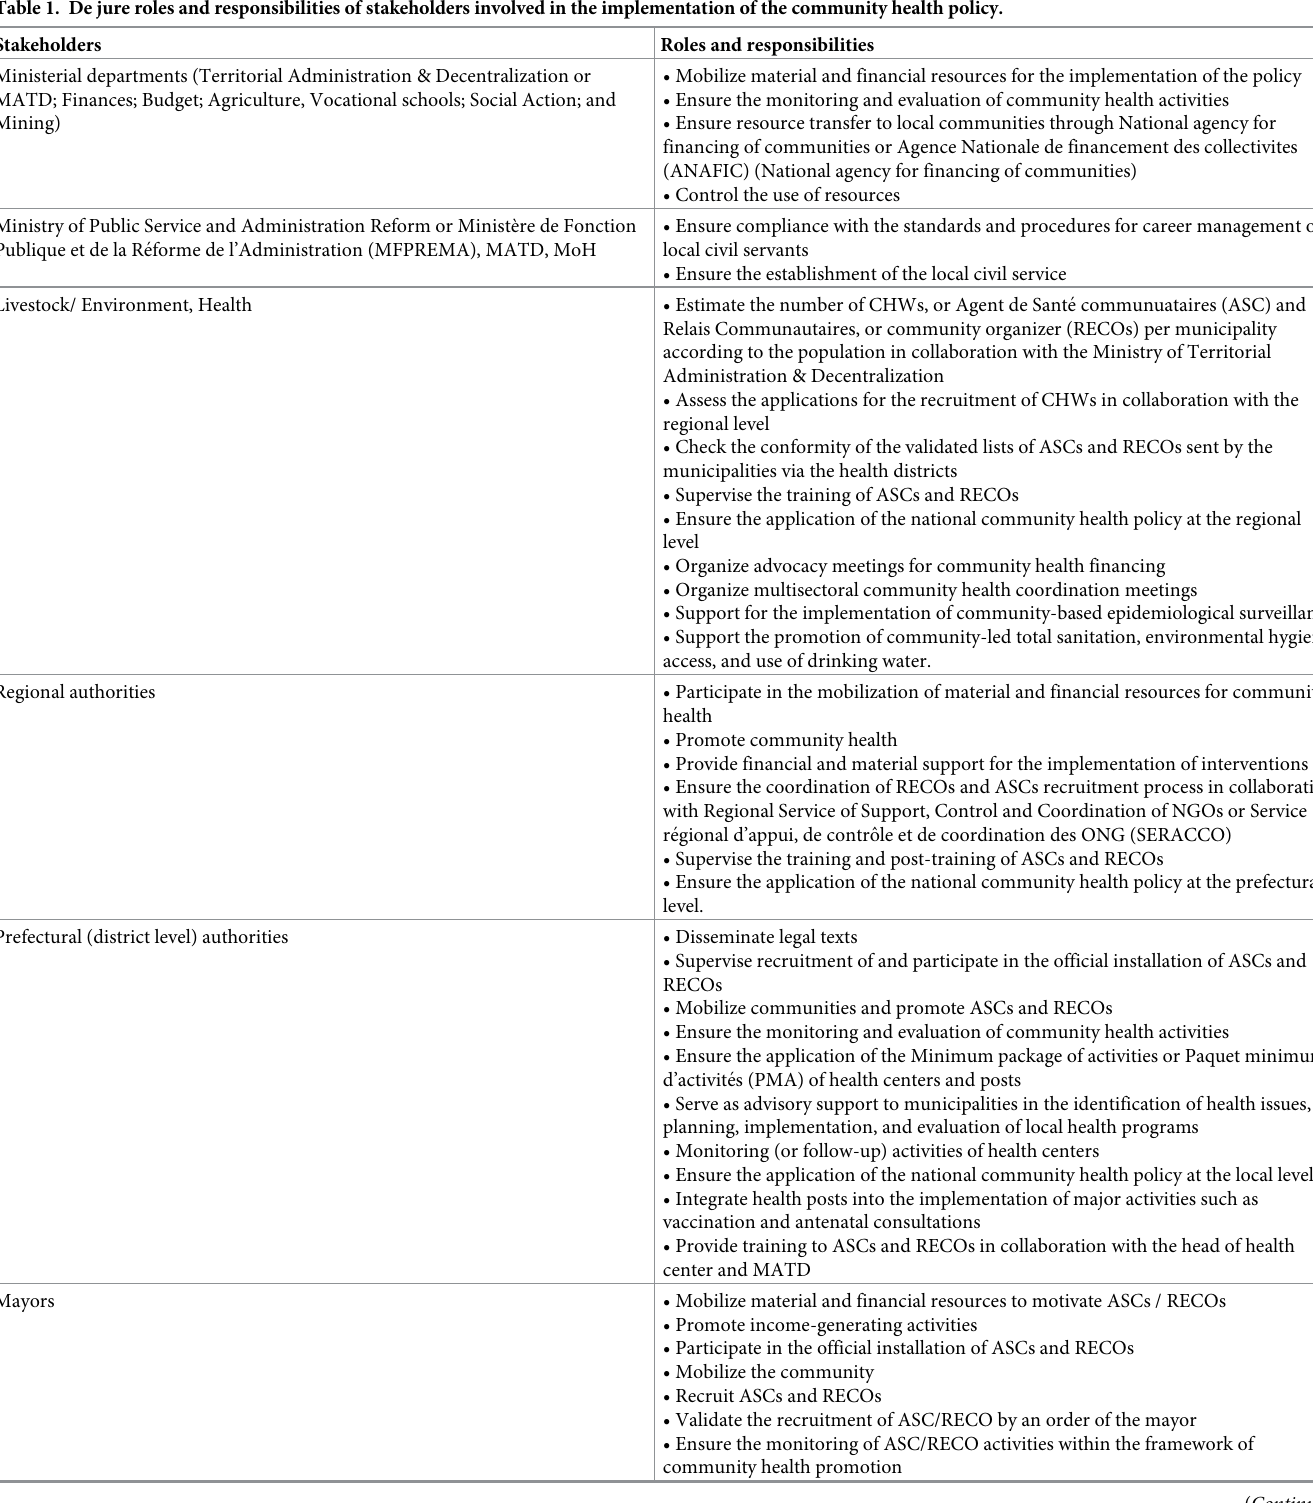
Table 1. De jure roles and responsibilities of stakeholders involved in the implementation of the community health